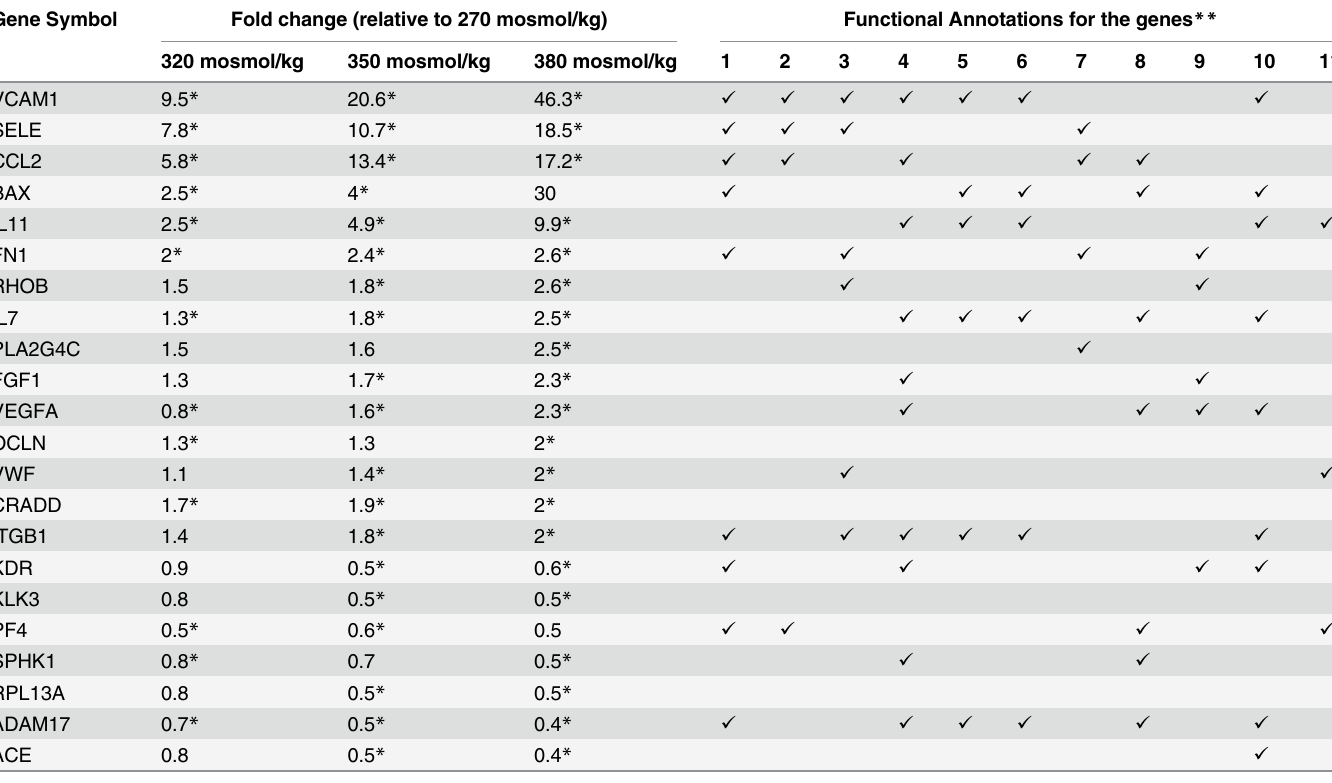
Table 1. Effect of high NaCl on expression of genes related to endothelial cell function in cultured HUVEC cells. Gene Symbol Fold change (relative to 270 mosmol/kg)